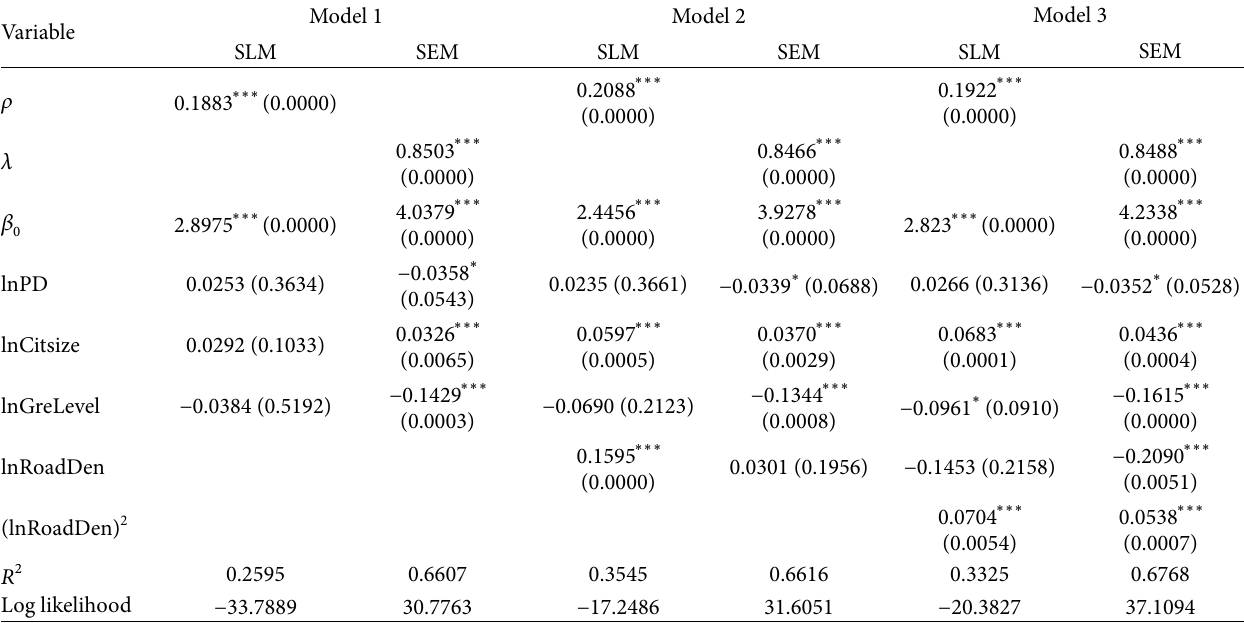
Table 4: Results of spatial